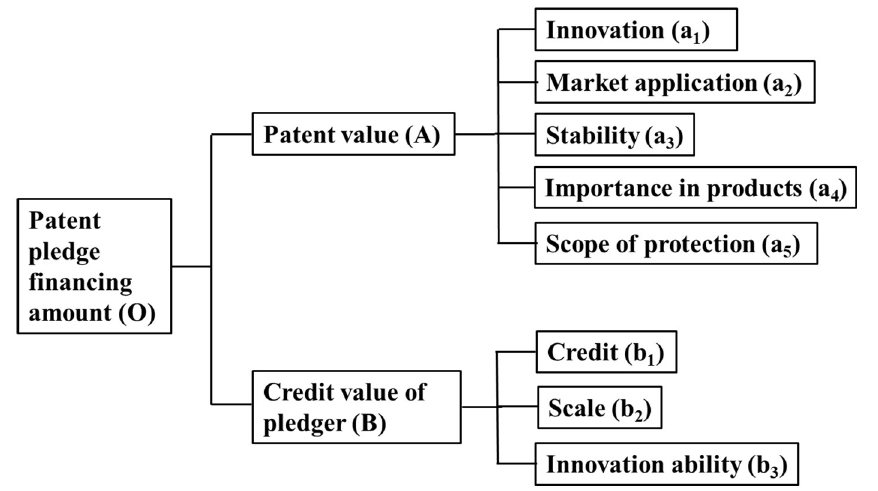
Fig 1. Index system for predicting the patent pledge financing